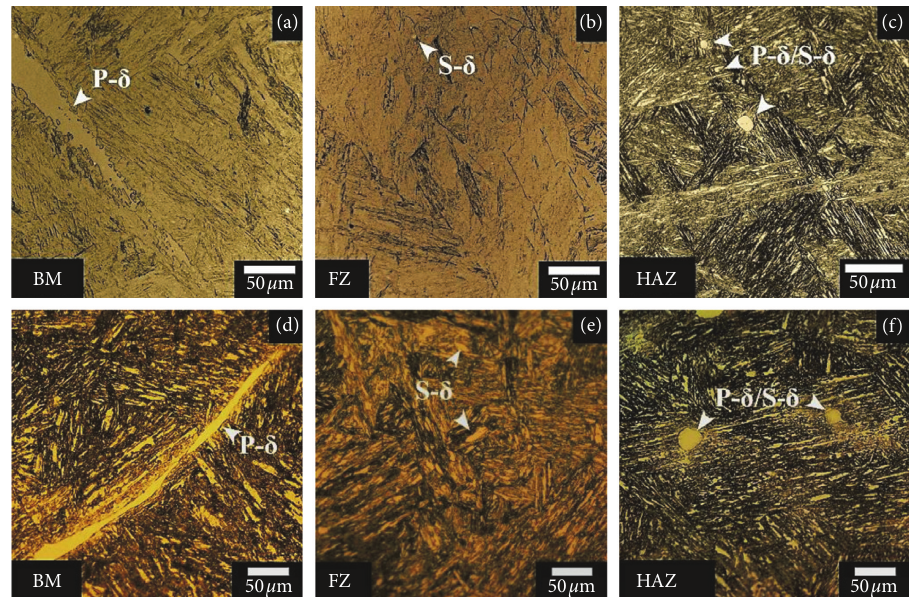
Figure 6: Microstructure of CA6NM in different regions of the EB welds (a) BM, (b) FZ, and (c) HAZ for the as-welded condition and (d) BM, (e) FZ, and (f) HAZ for the PWHTed condition.